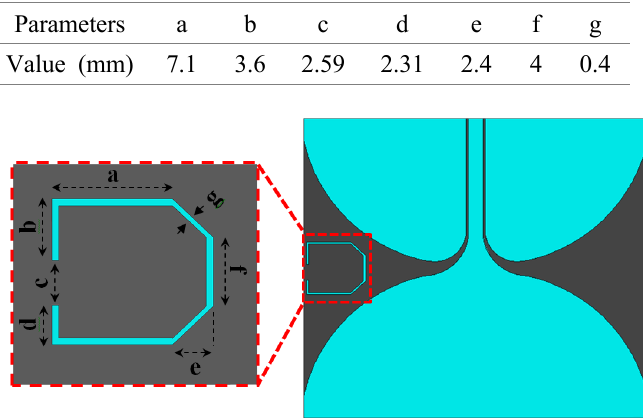
Figure 3: Proposed bi-directional antenna with single band- notch.